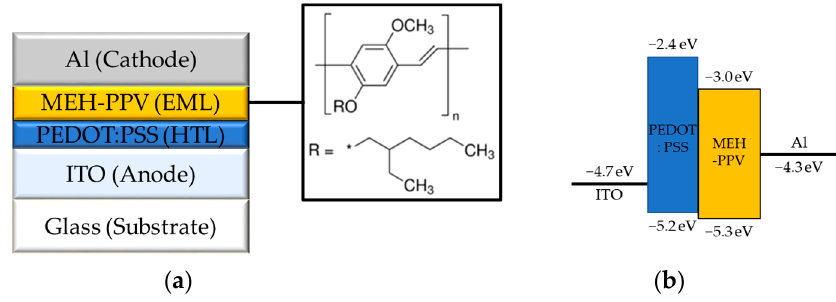
Figure 1. Fabricated OLED with MEH-PPV: ( a ) device structure and ( b ) energy level diagram. To fabricate the OLED devices, patterned ITO substrates (sheet resistance of 15 ohm/sq, active layer of 3 × 3 mm) were cleaned by an ultrasonic method with acetone, isopropyl alcohol, and distilled water for 30 min each, followed by UV treatment for 20 min. A HTL of PEDOT:PSS (P. VP AI 4083 Heraeus/Clevios, Leverkusen, Germany) was coated